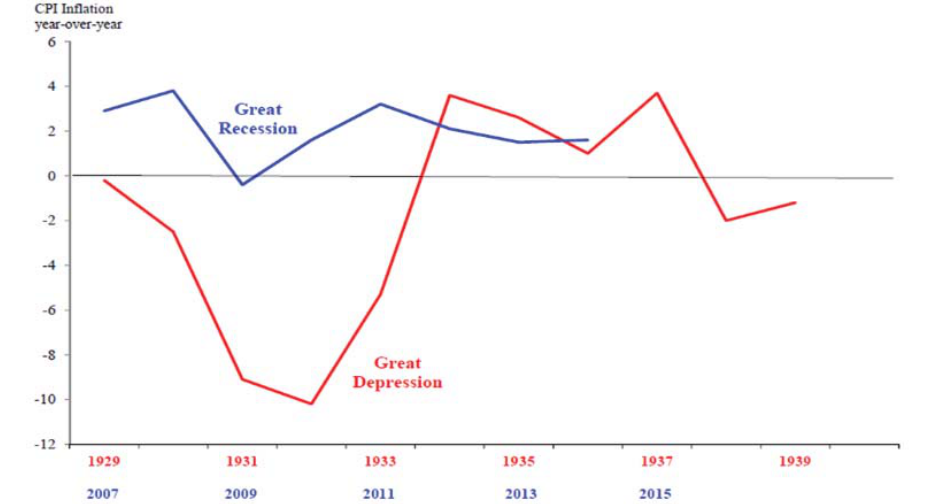
Fig. 3. Consumer price index measure of inflation for the United States Source: Anderson et al.